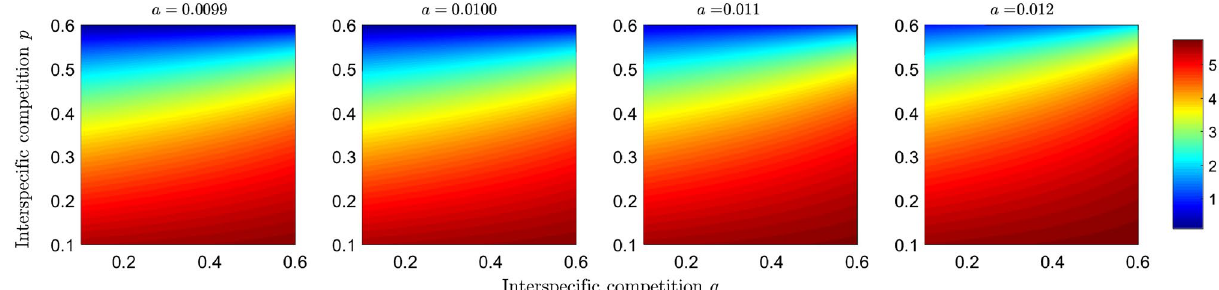
Figure 3. Effect of competition and predation on the basic reproductive number of the disease in the predators. ( 2,1 ) Simulations plot the R 0 given in Eq. (3) as a function of the competition parameters p and q under different scenarios of predation efficiency a , where ( q , p ) ∈ [ 0.1, 0.6 ] × [ 0.1, 0.6 ] . The color bar shows the numerical value of the basic reproductive